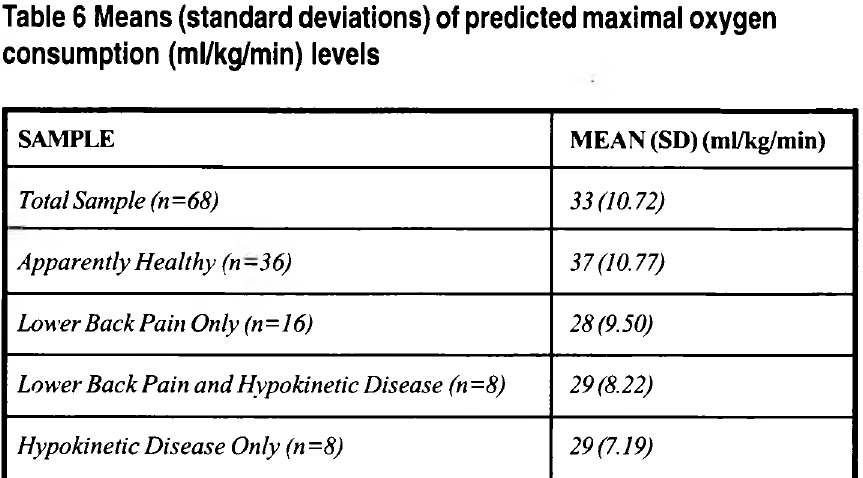
Table 6 Means (standard deviations) of predicted maximal